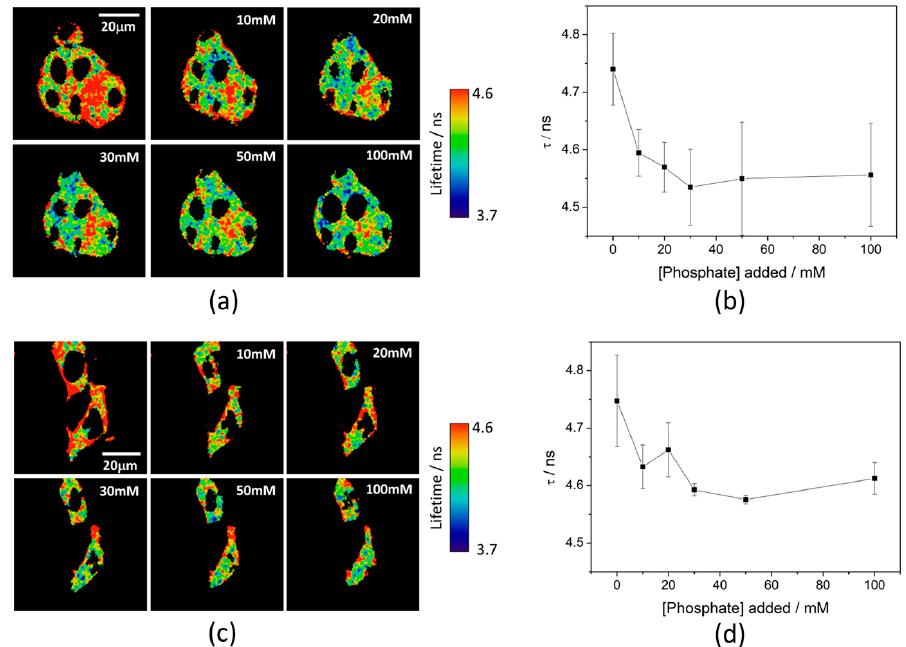
Figure 3. Phosphate response of the released 2Me-4OMe-TM in fluorescence lifetime imaging microscopy (FLIM) imaging. ( a ) Representative FLIM images of released 2Me-4OMe-TM in HepG2 cells, incubated with α -toxin for 20 min at different extracellular phosphate concentrations, and ( b ) the corresponding fluorescence lifetime τ in the cytoplasm pixels averaged over 10 repeated experiments. Error bars represent the standard errors. ( c ) Representative FLIM images of released 2Me-4OMe-TM in preosteoblast cells, incubated with α -toxin for 20 min at different extracellular phosphate concentrations, and ( d ) the corresponding fluorescence lifetime τ in the cytoplasm pixels averaged over four repeated experiments. Error bars represent the standard errors.